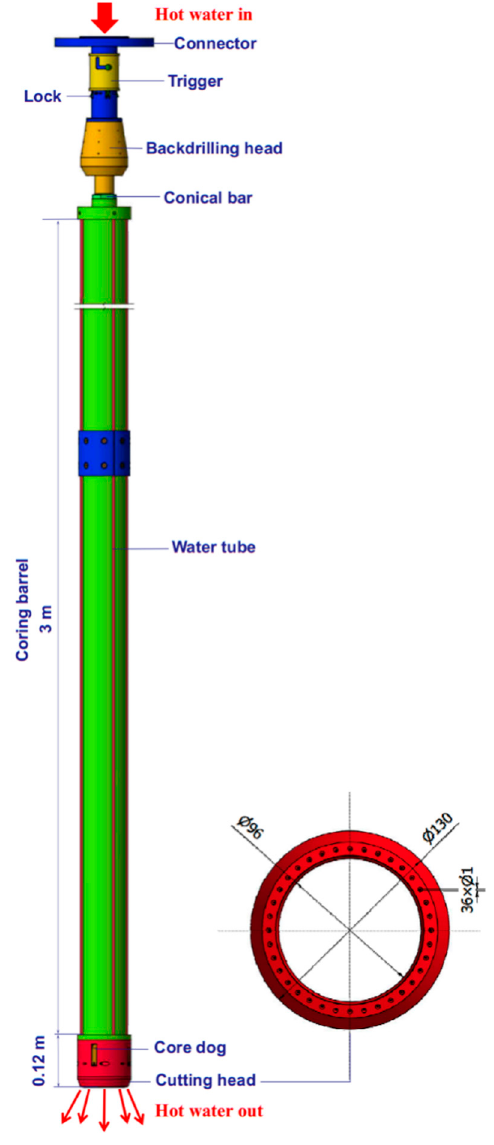
Figure 4. Overview of the hot water ice-coring drill.